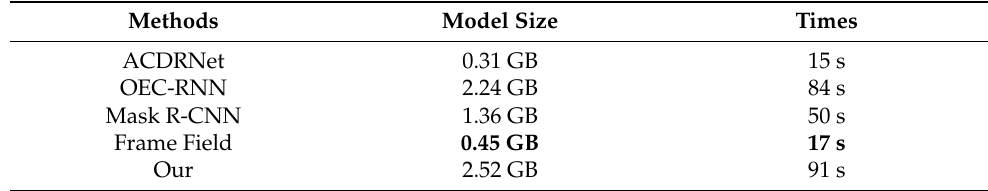
Table 4. The comparison of computational